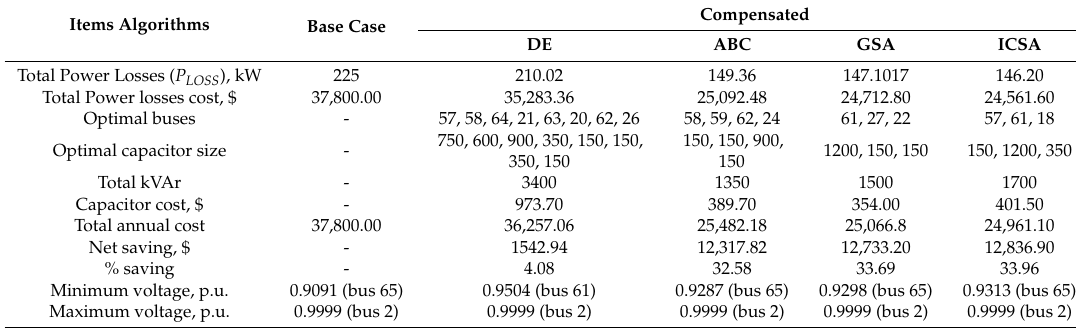
Table 14. Experiment result of 69-bus system.